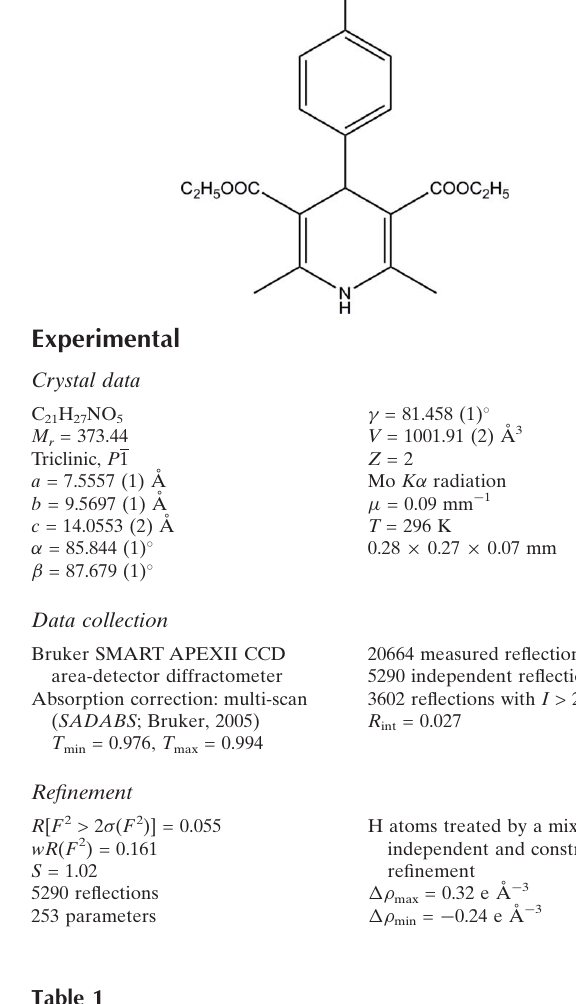
Hydrogen-bond geometry (A˚ , (cid:2)